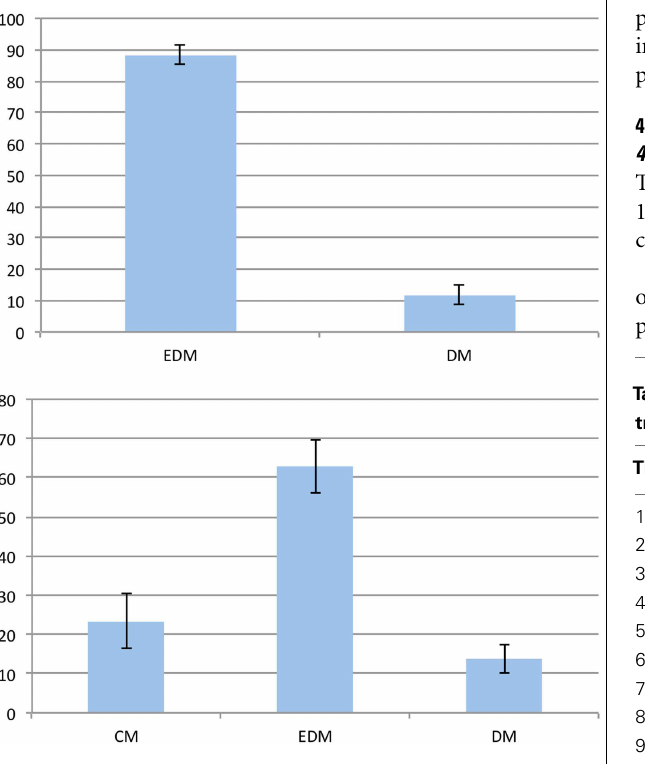
FIGURE 3 | Preferences in the first experiment .The vertical axis represents the frequency of the given answer.Top: 90˚ problems; bottom: 45˚ problems. Error bars show the standard error of the mean. EDM, equal-distance model; CM, cardinal model; DM, distorted models.